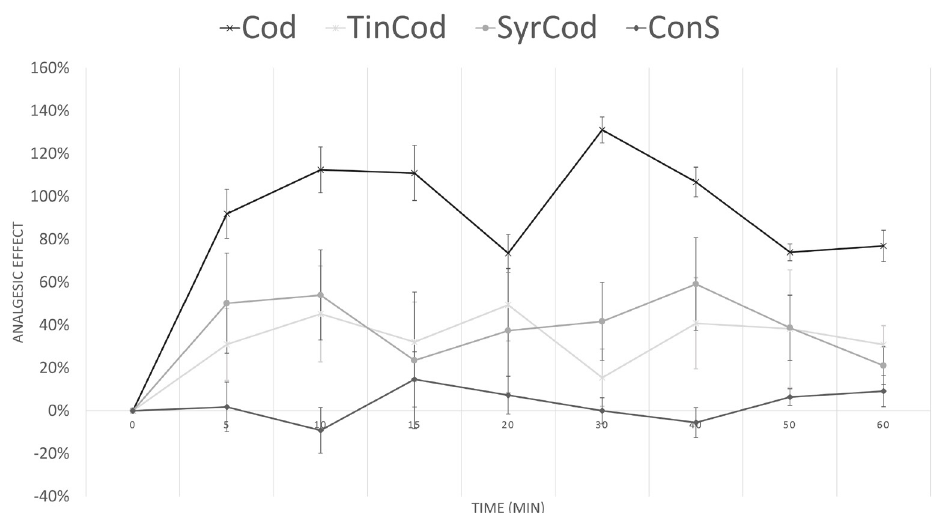
FIGURE 1 - Interactions between different Thyme formulations and codeine. Analgesic effect is expressed as a percentage of prolongation of measured reaction time compared to control reaction time (Abbreviations - ConS: control group, Tin: thyme tincture, Syr: thyme syrup, Cod: codeine, TinCod: thyme tincture and codeine, SyrCod: thyme syrup and